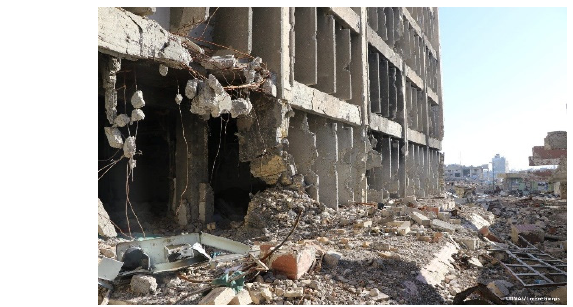
Figure 4. Photographic documentation of the relocatable hospital in Mosul. In July 2017, Mosul city was liberated from ISIS. The relocatable hospital was con- structed by GIZ (German Agency for International Cooperation GmbH), the main Ger- man development agency, in partnership with the Ministry of Health. The relocatable hospital in Mosul was built on the same site as Al ‘Salaam hospital on a single floor and contains more than 600 containers, as shown in Figure 5 and Appendix A Figure A1. Two types of containers were used; first, a high cube of 13.09 m 2 area, 2.90 m height, and second a high cube of 26.77 m 2 , 2.90 m height, as shown in Figure 6, was used. To ana- lyze the case study, eight departments of the hospital were chosen (Emergency, Dialysis, Pediatric, Outpatient, Radiology, Endoscopy, Laboratory, and Wards).